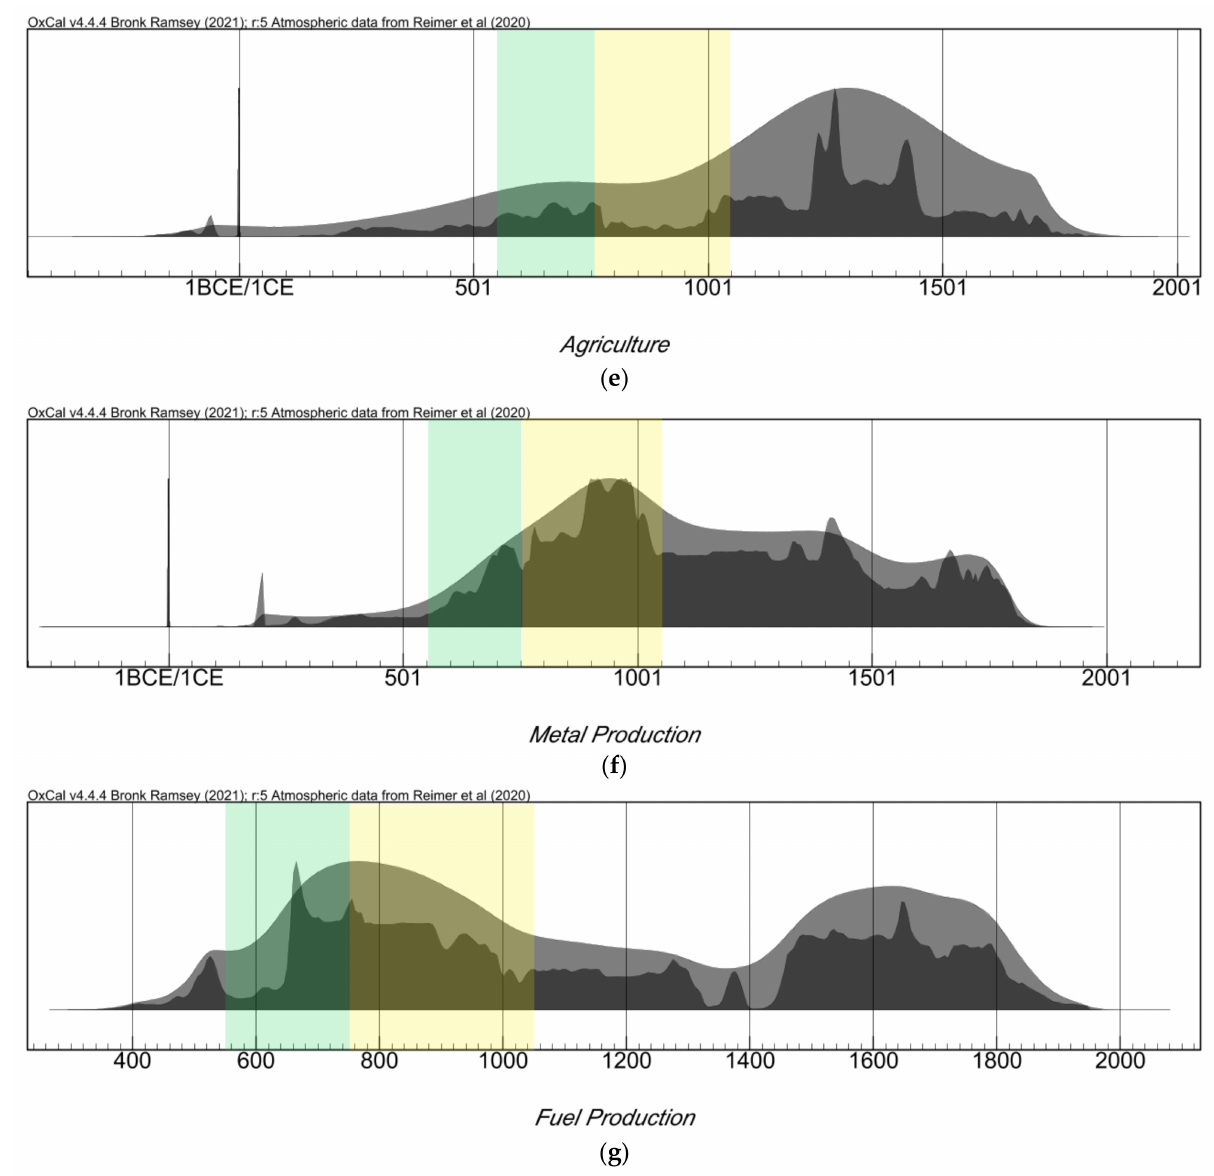
Figure 4. Kernel density estimation plots for different land uses as described in the text. ( a ) Settlement; ( b ) Activity areas; ( c ) Hunting; ( d ) Land claim; ( e ) Agriculture; ( f ) Metal production; ( g ) Fuel Production. Blue boxes generally denote the Neolithic Period to the Bronze Age; green boxes mark the general Vendel Period; and yellow boxes mark the general Viking Age. Grey curve = KDE_plot; Black = summarized calibration curve; samples were analyzed using KDE modelling in OxCal 4.4